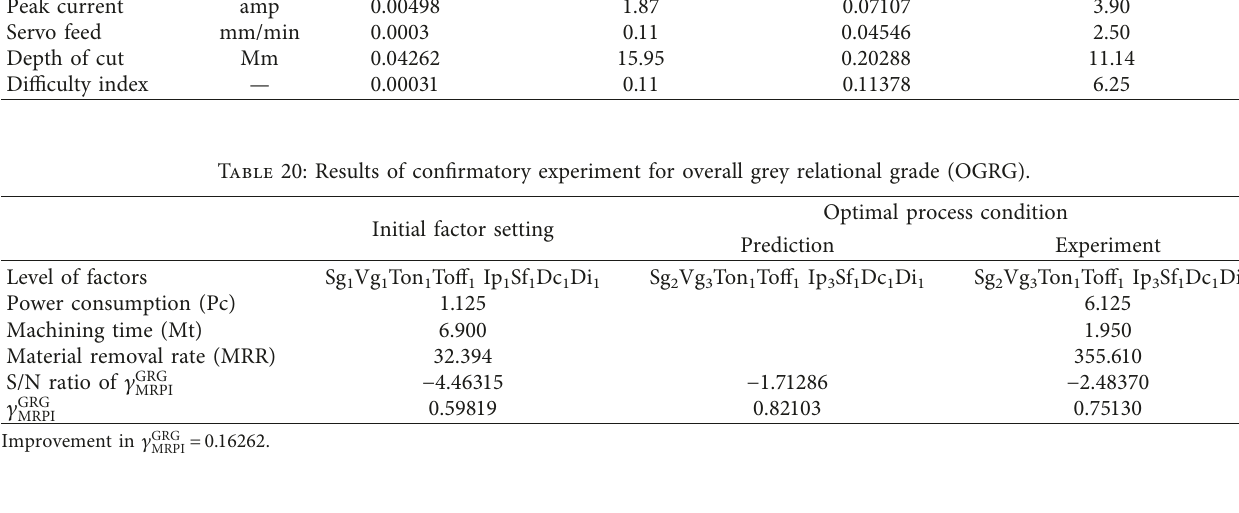
Table 21: Results of confirmatory experiment for composite principal component ( ψ ) .